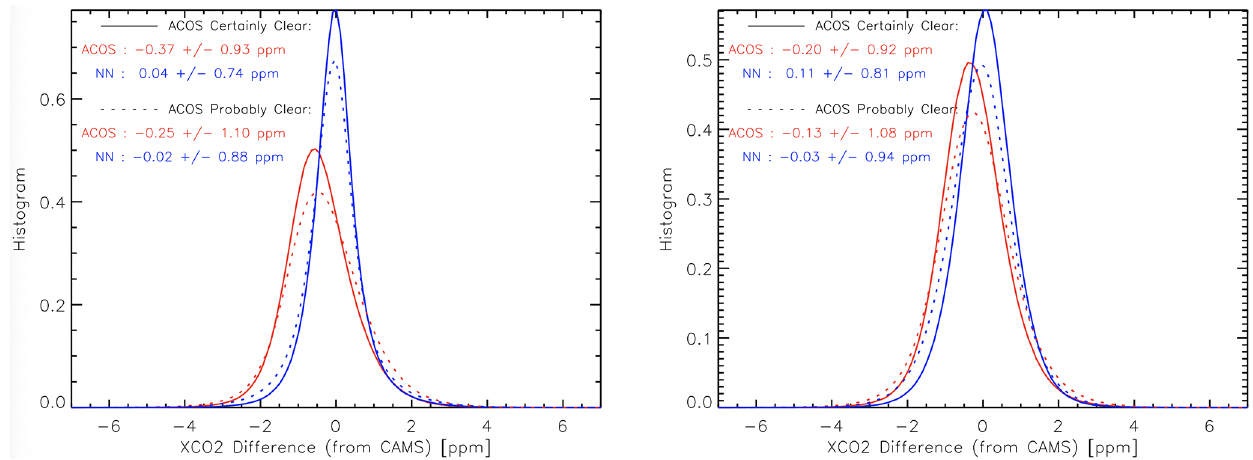
Figure 7. Histogram of the differences between either one of the two satellite datasets and the CAMS model. We distinguish cases when the flag cloud_flag_idp is “certainly clear” and “probably clear”. The left figure is for the nadir dataset, whereas the right figure is for the glint.